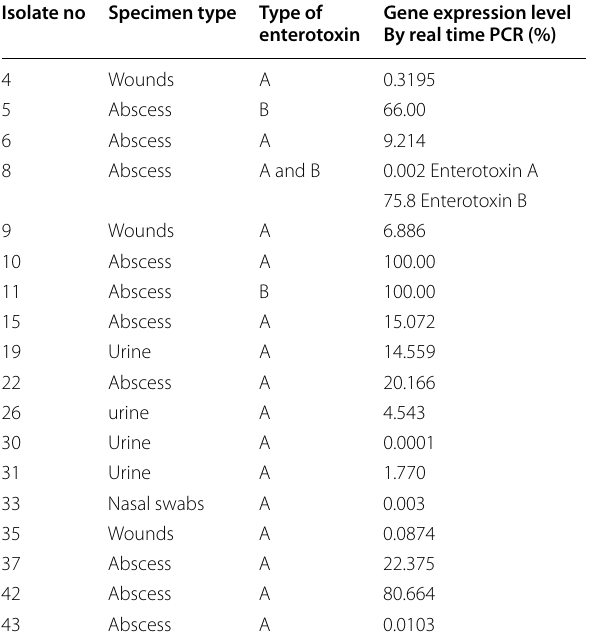
Table 4 Distribution of enterotoxin genes pattern and relative gene expression among isolation sources